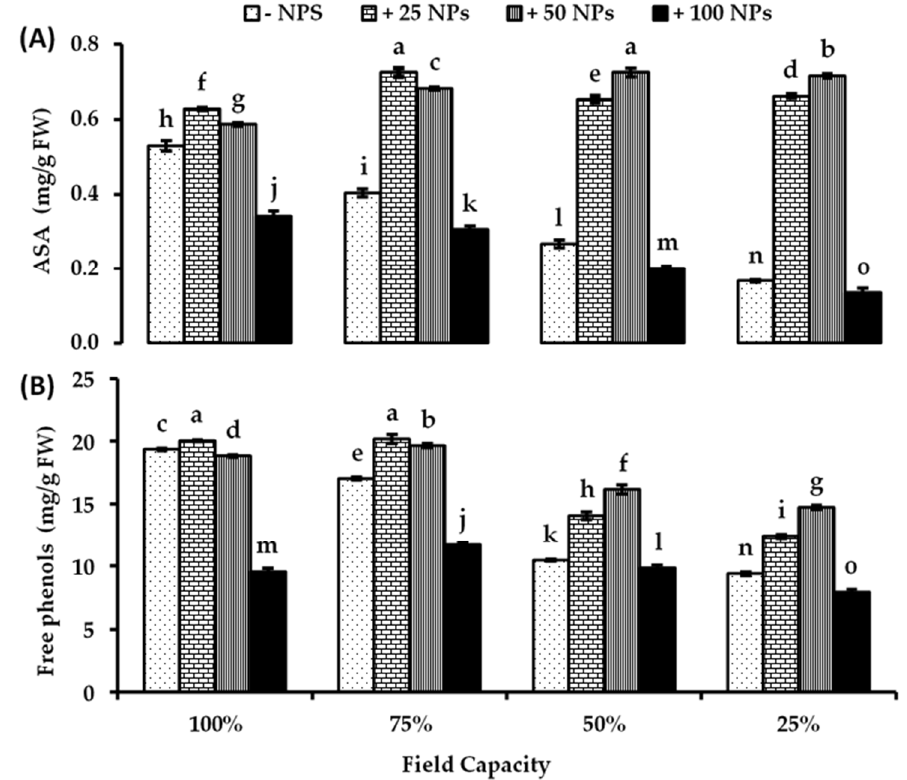
Figure 3. Antioxidants, ( A ) ascorbic acid (AsA), and ( B ) free phenols concentration in tomato leaves as affected by foliar spraying with different concentrations of ZnO-NPs under different levels of drought stress. Each point represents a mean value of three replicates ( n = 3) with vertical bars representing the standard error of the mean. Bars with different letters indicate a significant difference ( p < 0.05) between Zn-O NPs treatments at all studied water levels as determined by two-way ANOVA and Bonferroni multiple comparison test.